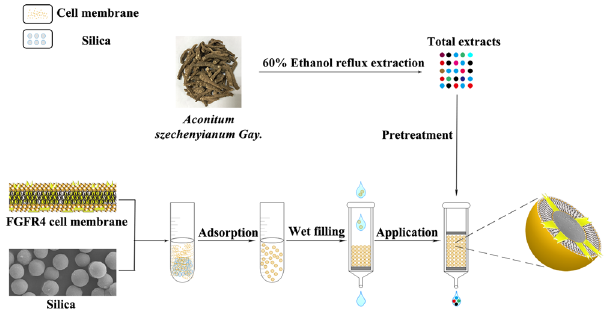
Figure 1. Schematic illustration of the procedures of FGFR4/CMCSPs SPE system.